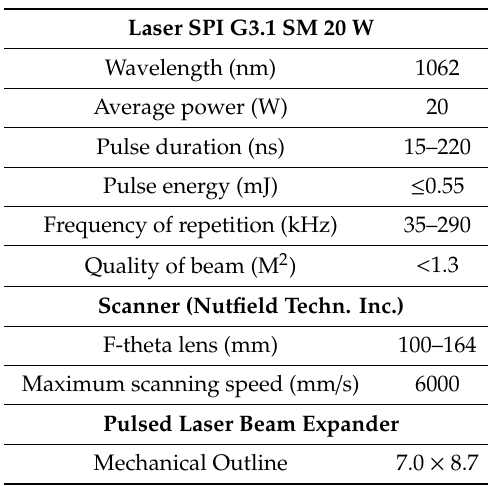
Table 1. Parameters of the devices of the laser system.